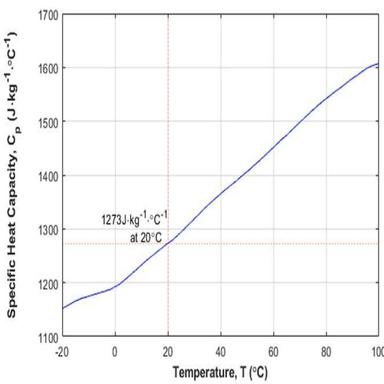
Specific Heat Capacity Cp against Temperature T for the aerogel composite. Cp value at 20 ◦C is taken for subsequent hygrothermal study.